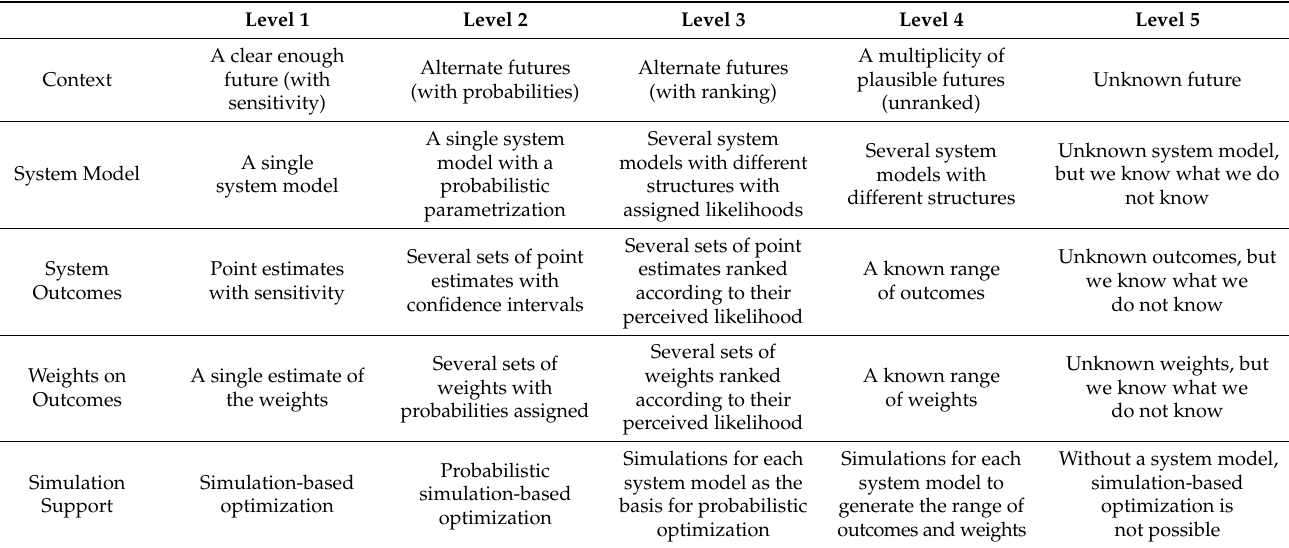
Table 2. Progressive Transition of Levels of Uncertainty and System